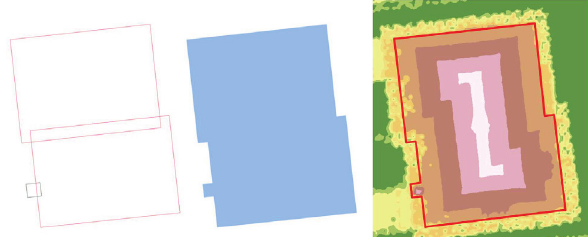
Figure 8. More detailed footprint is reconstructed from the point cloud with high density.